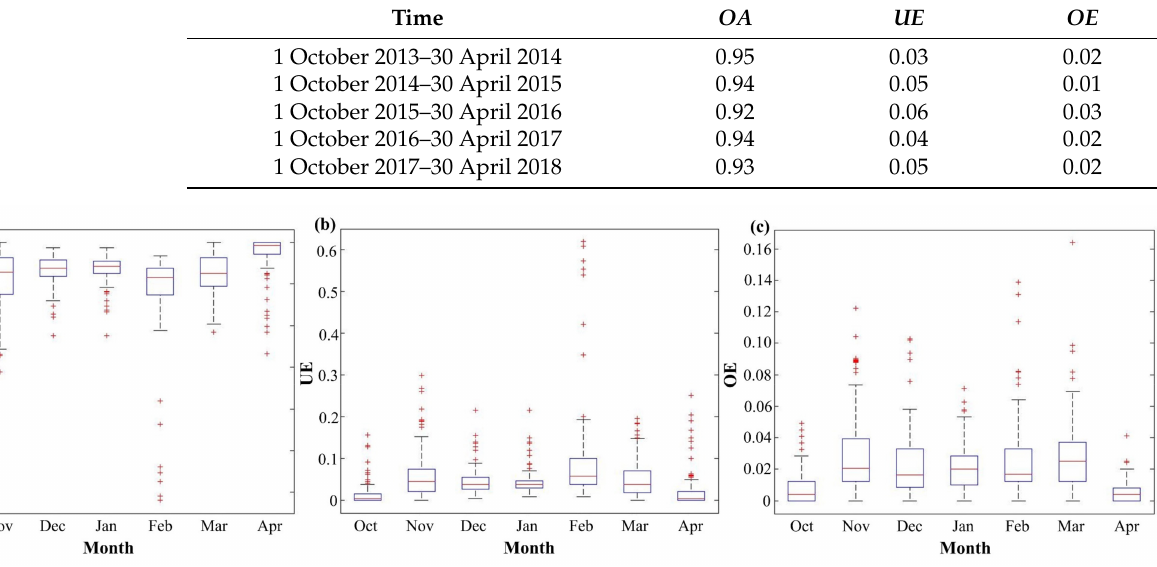
Figure 2. Boxplots of the three evaluation indices ( a ) OA, ( b ) UE and ( c ) OE in different